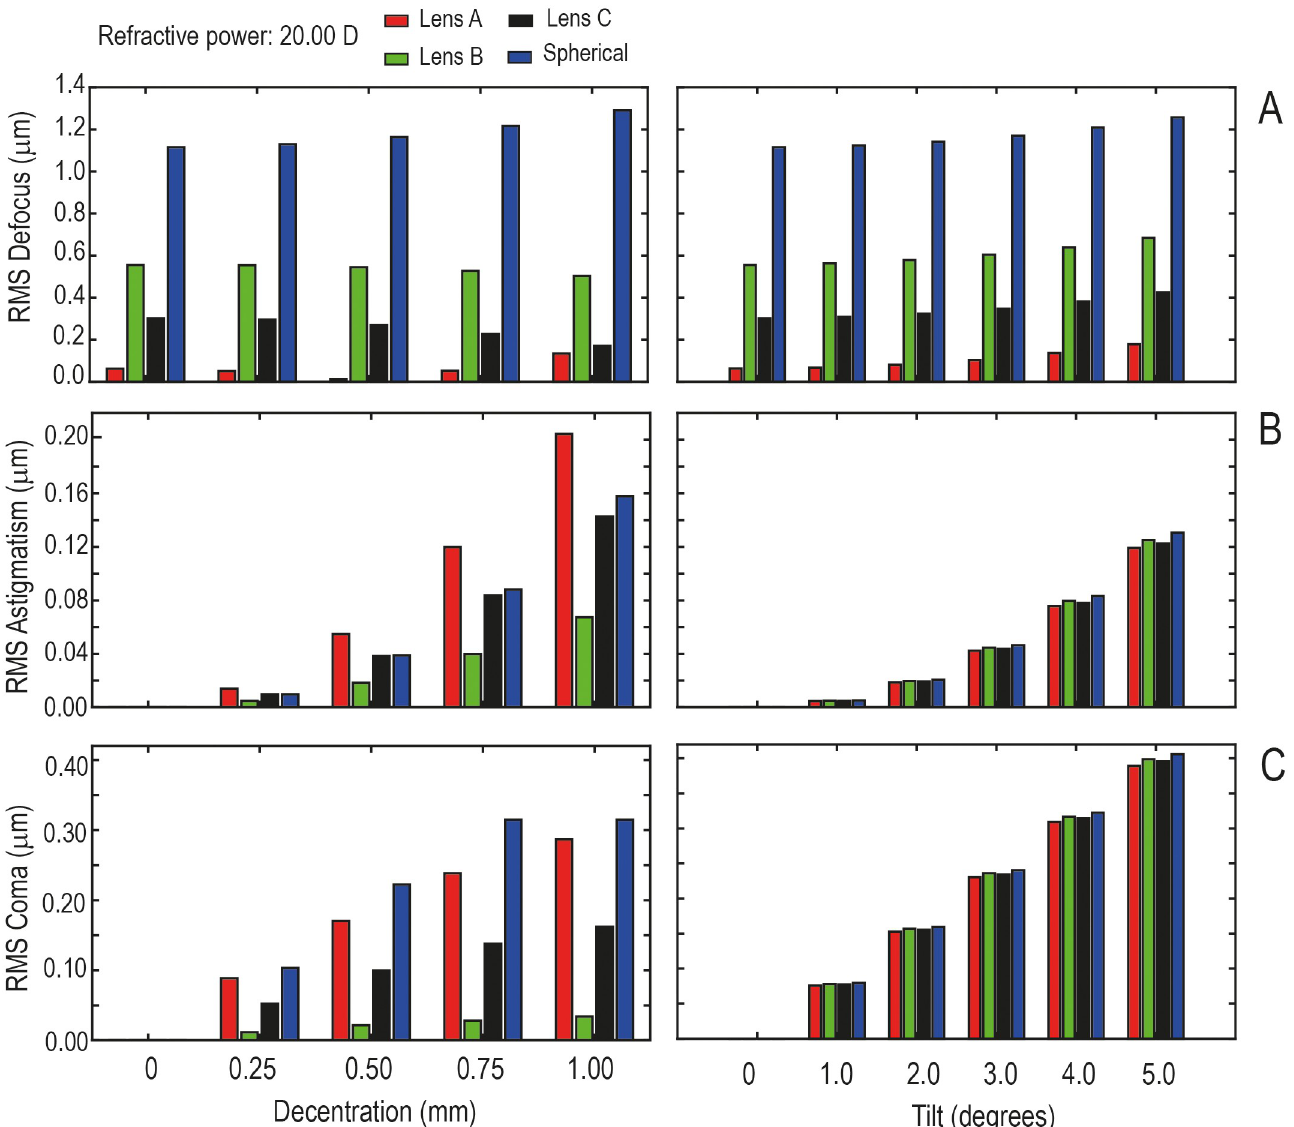
Fig 3. Theoretical results of RMS for decentration (left column) and for tilt (right column) for a refractive power of +20.00 D and a 6.00 mm diameter pupil: A) RMS defocus, B) RMS astigmatism and C) RMS coma.